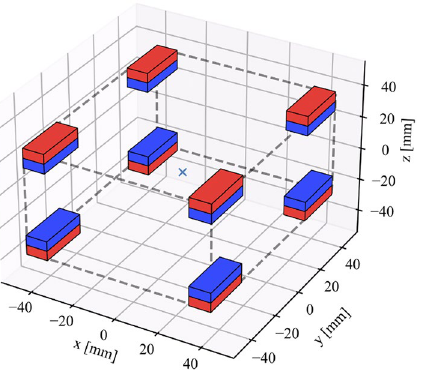
Figure 2. Configuration of magnets arranged on eight vertices of a cuboid (four magnets at each vertex). The red and blue colours represent the two poles of the magnets. The magnetic field direction points from blue to